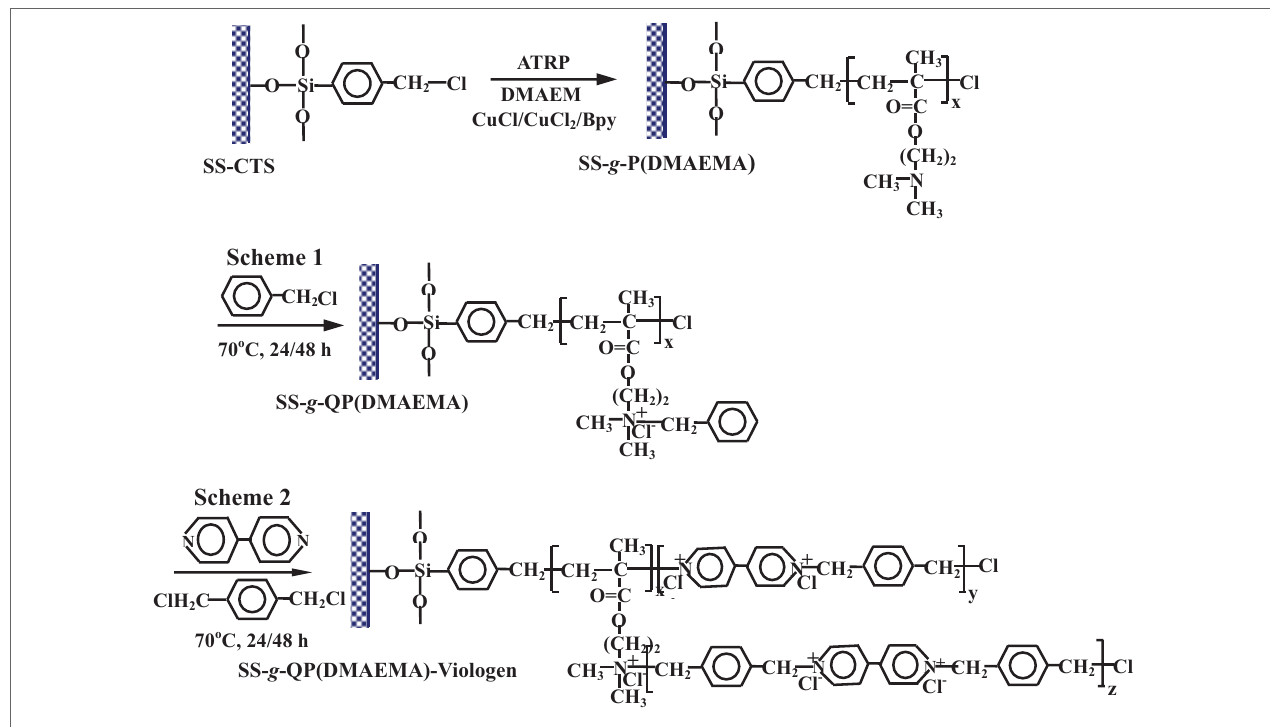
FiGURe 4 | Surface-initiated atom transfer radical polymerization of DMAEMA and subsequent quaterization of PDMAEMA using two different schemesfrom stainless steel surfaces. Reprinted with permission from Yuan et al. (2009c). Copyright 2009 Wiley Periodicals